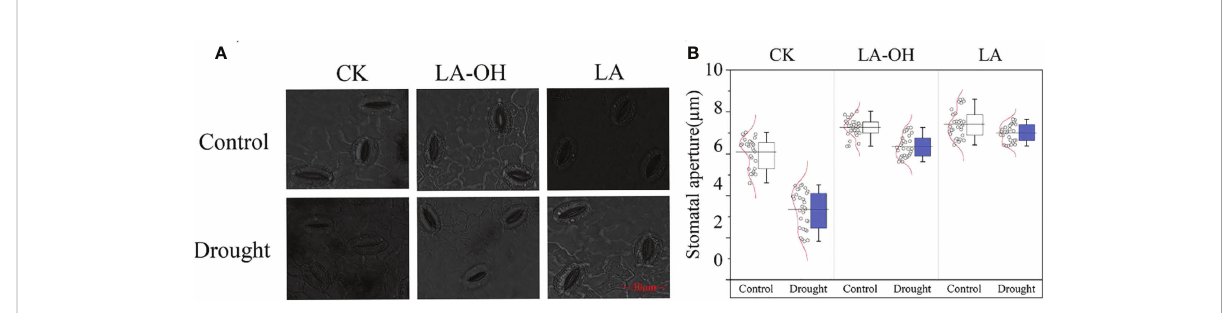
FIGURE 4 Effects of LA-OH and LA on the sizes of stomatal apertures of P. persica leaves under drought stress (A) light microscopeto visualize showed the characteristics of stomata; (B) Stomatal aperture area). Data are mean ± SD (n = 3). Duncan ’ s test and ANOVA were used. Signi fi cant differences (P < 0.05) are indicated by different